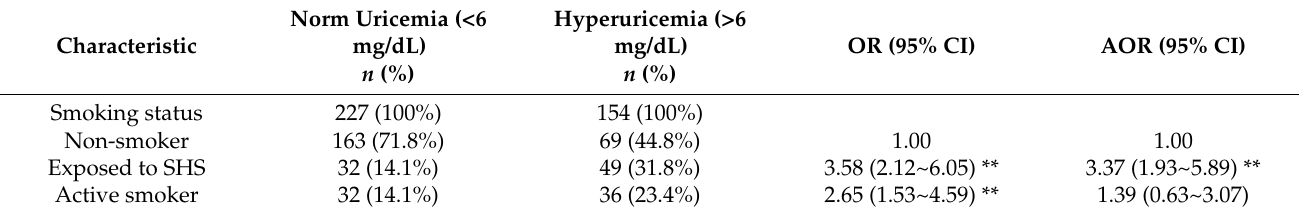
Table 5. Odds ratio (OR) and adjusted odds ratio (AOR) for the risk of hyperuricemia ( N =